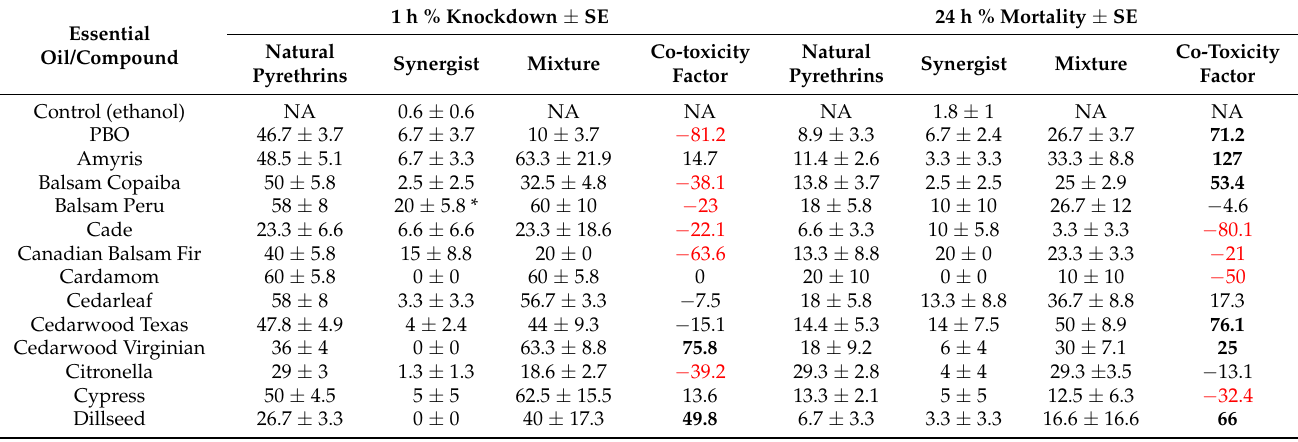
Table 1. Percentage 1 h knockdown and 24 h mortality values for natural pyrethrins (LD 25 ), plant essential oils or PBO synergists (2 µ g/insect), mixture of natural pyrethrins + synergist, and the calculated co-toxicity factors for each mixture. Essential